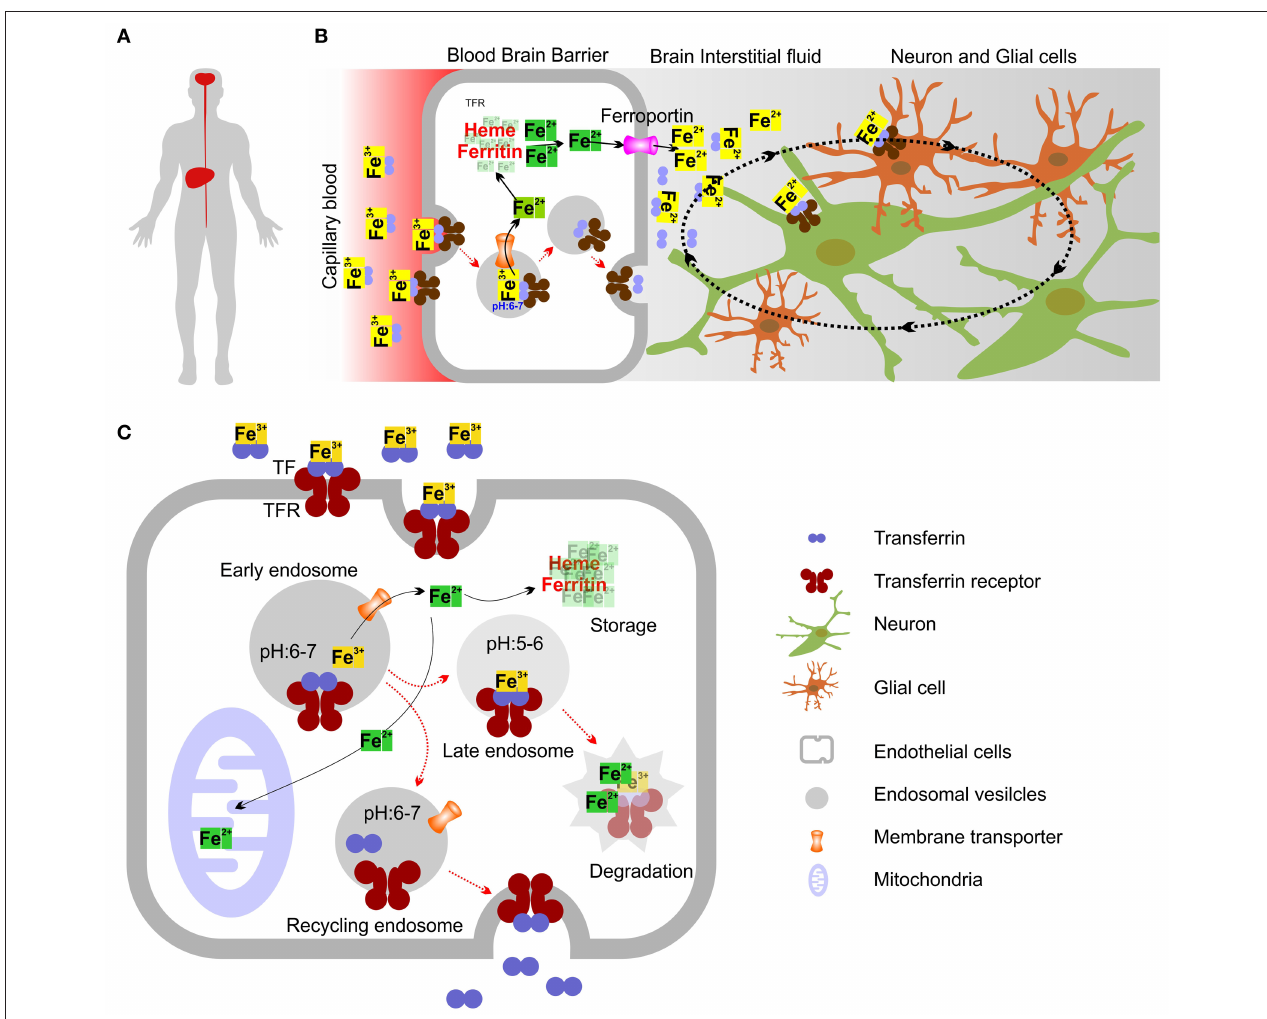
FIGURE 11 | Model showing intracellular iron transport and transport across Blood-Brain Barrier (BBB). (A) Diagrammatic representation showing Liver and brain as 2 organs in human involved in the production of TF. (B) Mechanism showing how iron crosses the BBB. Holo-TF circulates through the brain capillaries and comes in contact with the luminal TFR which then internalize TF bound iron. The iron exporter ferroportin may allow iron to cross the abluminal membrane of the endothelial cell to enter the interstitial fluid. Most TF in the brain interstitial fluid is synthesized and secreted by oligodendrocytes as Apo-TF. Neurons and glia may acquire most iron through the TFR and holo-TF that is present in the interstitial fluid and cerebrospinal fluid. (C) Molecular mechanism showing intracellular iron transport. Most cellular uptake of ferric iron (Fe 3 + ) occurs via receptor-mediated endocytosis of TF. Fe 3 + ions form complexes with the high-affinity iron binding TF, which then binds to TFR. After endocytosis of TFR, the acidic environment of the early endosomes triggers the release of Fe 3 + from the TF-TFR complex, which is recycled to the plasma membrane via recycling endosomes. Ferric reductases localized to the endosome reduce Fe 3 + (ferric) to its Fe 2 + (ferrous) form before Fe 2 + is released into the cytosol by the divalent metal transporter-1 (DMT1) in an H + -dependent manner. Fe 3 + may also be sorted into late endosomes (LE) and lysosomes (LY), where it is reduced to Fe 2 + by ferric reductases. In LE and LY, Fe 2 + can also be released by other endo-lysosomal iron release channels/transporters. Iron can then bind to the chaperones that donate iron to specific target proteins (not shown) (Philpott, 2012) or enter mitochondria through the dedicated mitochondrial iron transporters (Chen et al., 2009), where it is used for the synthesis of iron–sulfur clusters and haem (Rouault, 2013). Iron can also be stored in cytosolic proteins such as ferritin, which can sequester up to 4,500 iron atoms (Arosio et al., 2009). Ferritin sequestration of iron prevents free iron from reaching high concentrations in the cytosolic and nuclear compartments (Arosio et al., 2009). Degradation of ferritin in lysosomes leads to the formation of disorganized iron-rich deposits known as haemosiderin (not shown) (Cohen et al.,